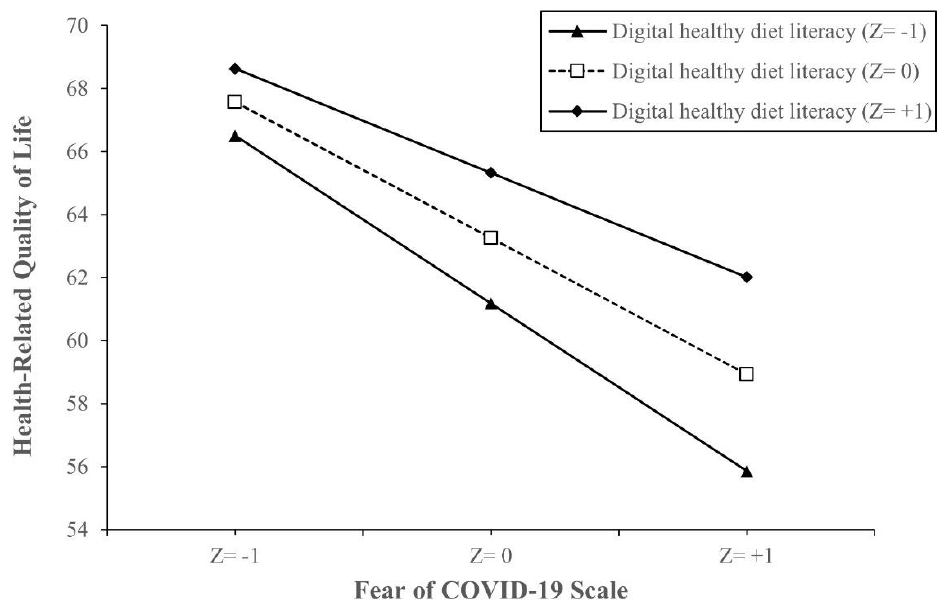
Figure 2. Simple slope plot of interaction between digital healthy diet literacy and fear of COVID-19 on health-related quality of life (N = 4348). Note: Z = − 1, one SD below the mean; Z = 0, the mean; Z = +1, 1 SD above the mean. Z-score is the number of SD above or below the mean. Abbreviations: SD, standard deviation.